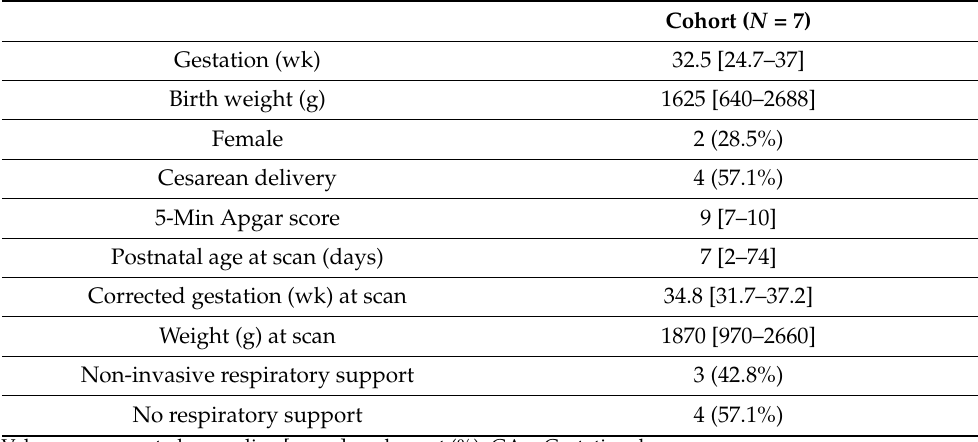
Table 2. Clinical characteristics of the cohort of neonates.